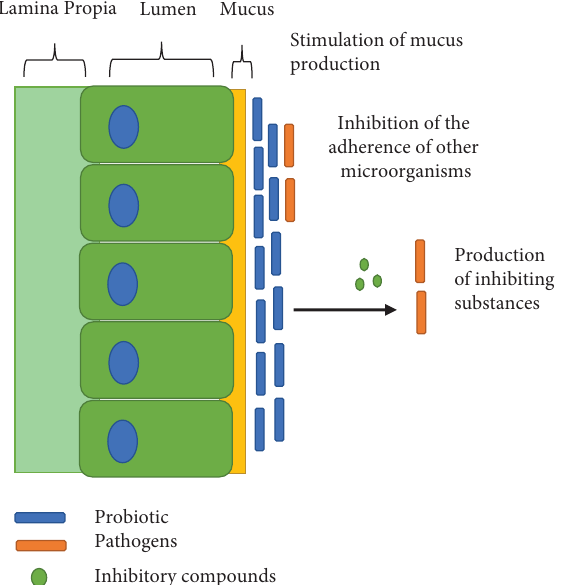
Figure 1: Mechanisms of pathogen inhibition by LAB